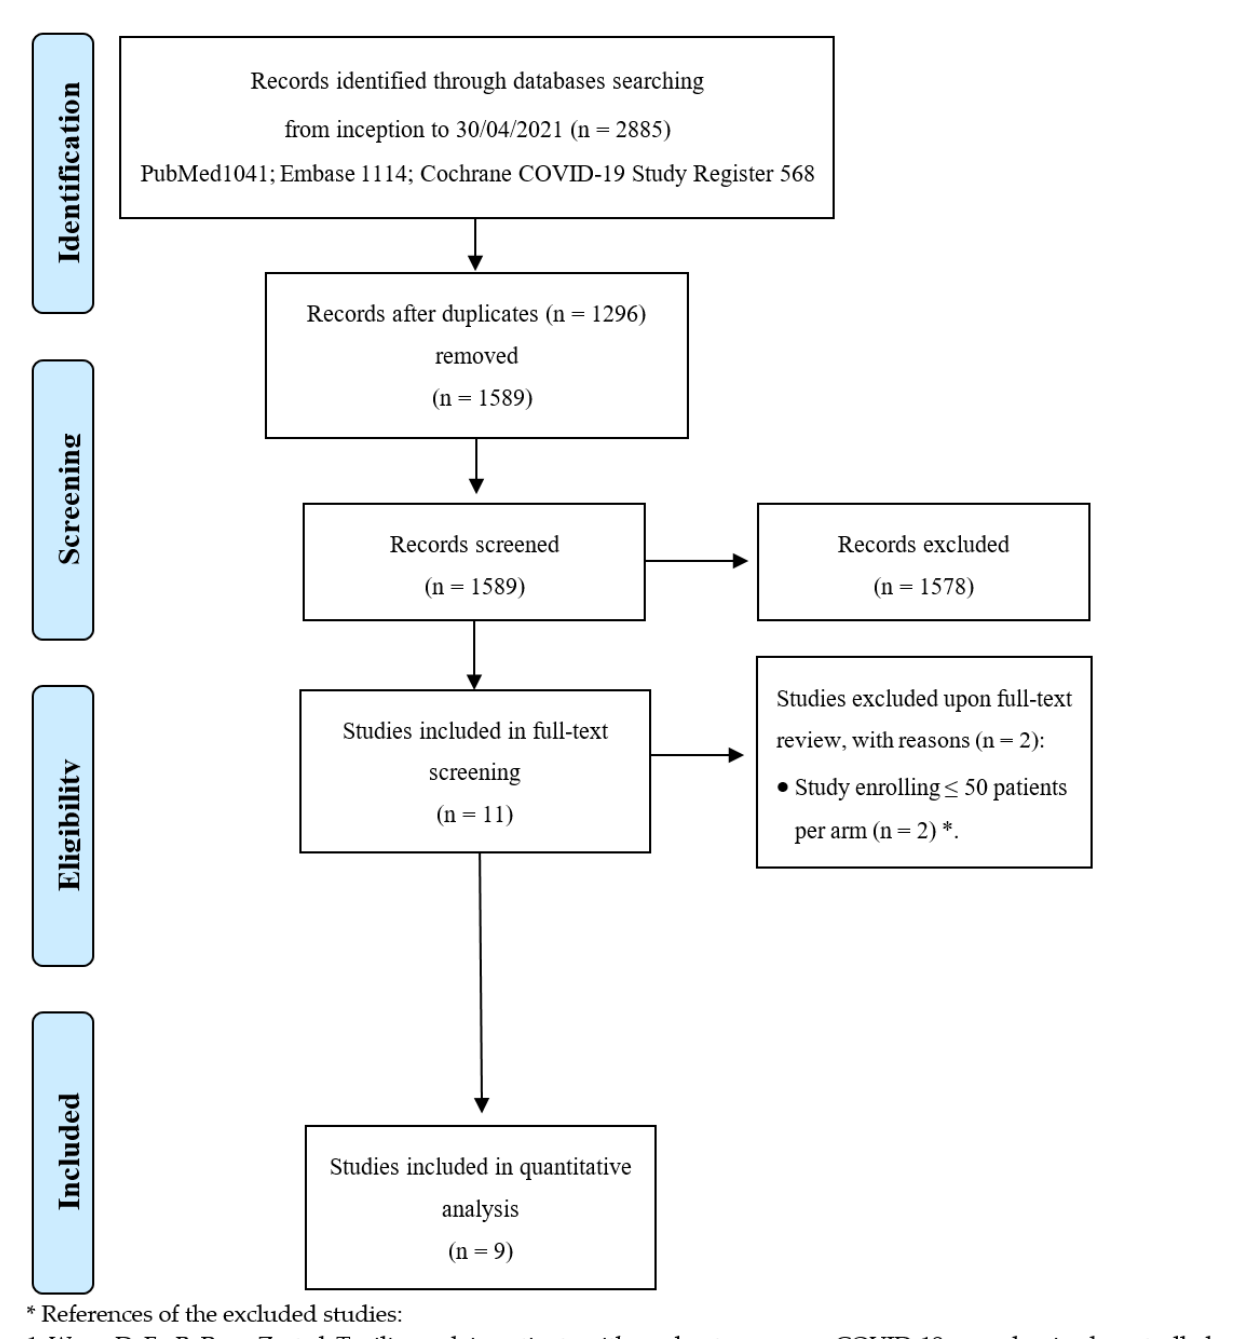
Figure 1. PRISMA diagram: results of the literature search and flow diagram for the selection of eligible studies.